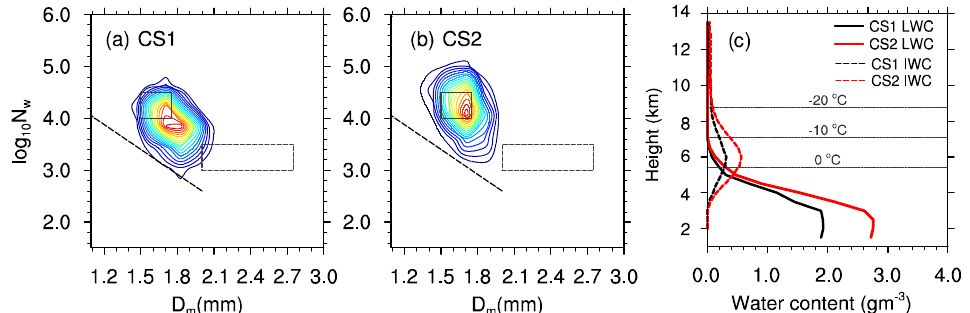
Figure 9. Frequency of occurrences of D m (mm) and log 10 N w (units of N w : mm − 1 m − 3 ) at 1-km altitude for ( a ) CS1 CCs and ( b ) CS2 CCs. The outermost line represents 5% contours, contour ranges from 5 to 100% with an interval of 5%.The gray dashed line denotes the fitting line for stratiform precipitation, while two gray rectangles represent the maritime and continental convective clusters in D m –log 10 N w space from Bringi et al. [41]; ( c ) The vertical profiles of LWC (solid lines; unit: g m − 3 ) and IWC (dashed lines; unit: g m − 3 ) averaged over the CS1 CCs (black lines) and CS2 CCs (red lines). The black dashed lines represent the level of 0 °C, − 10 °C, and − 20 °C from bottom to top, respectively. The analysis period of CS1 and CS2 is as in Figure 8.